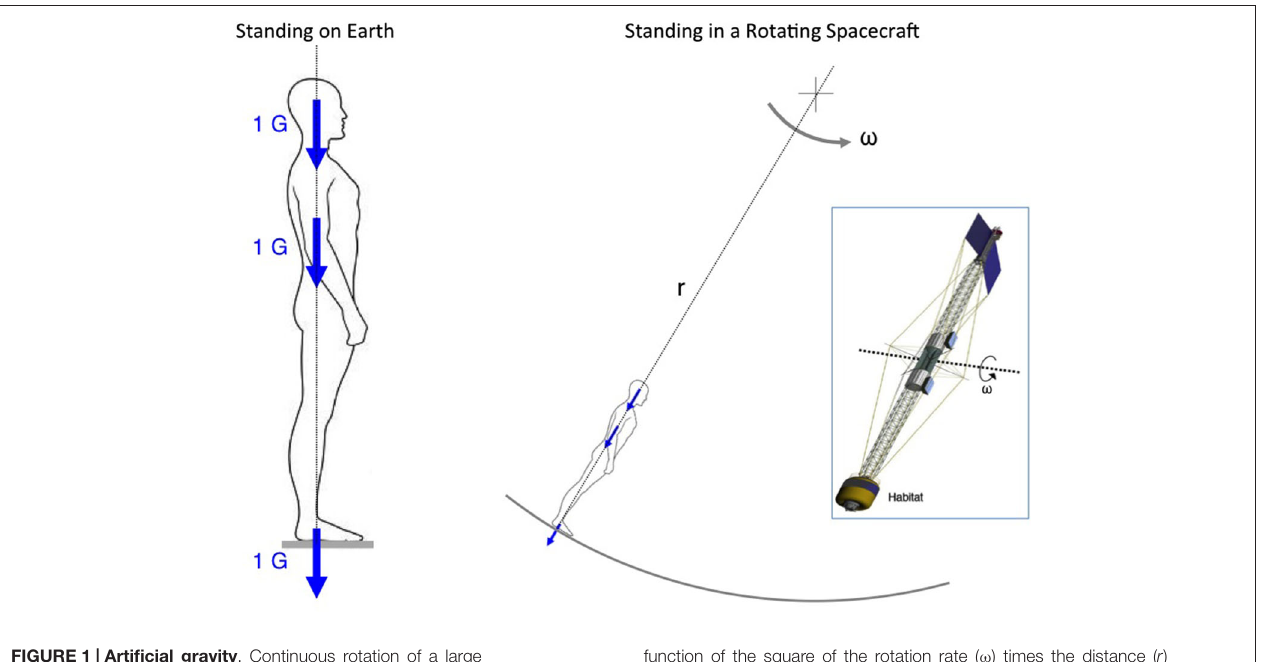
FIGURE 1 | Artificial gravity . Continuous rotation of a large spacecraft that creates a centrifugal force of 1 G in the habitat would give the static crewmembers the sensation of standing upright as on Earth. The magnitude of the centrifugal force is